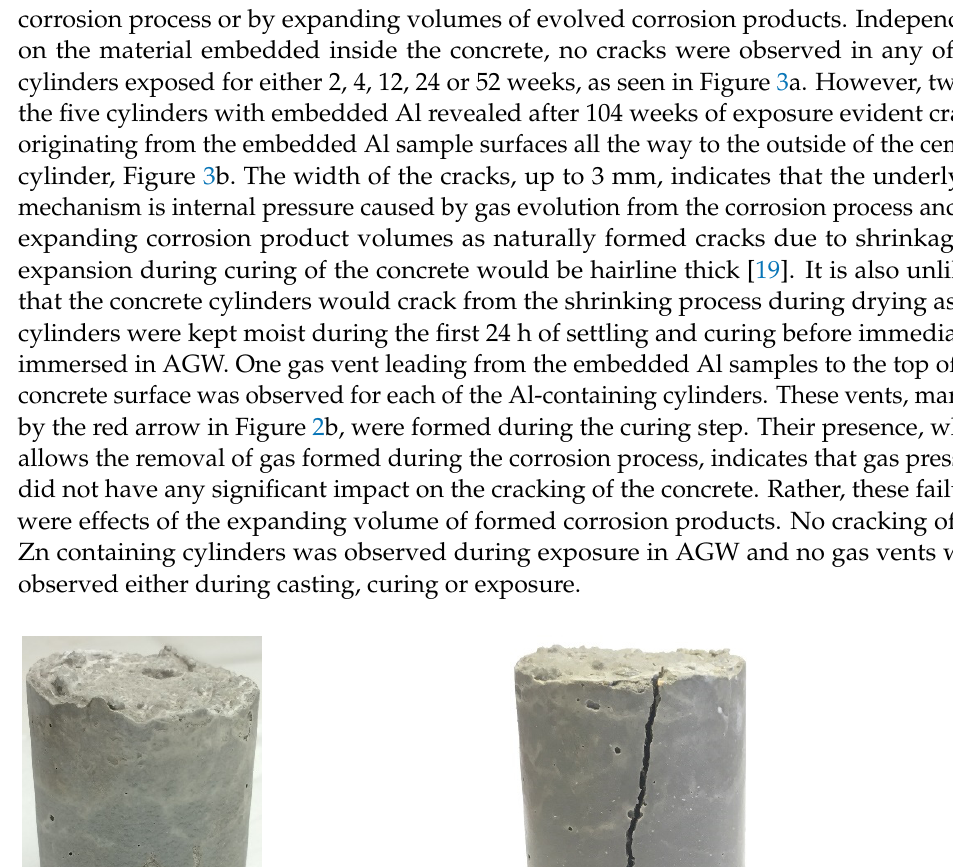
Figure 2. ( a ) Gas bubbles on the surface of wet concrete containing Al samples minutes after fin- ished pouring the concrete into moulds; ( b ) Gas vent outlet on the upper surface of concrete cured for 20 h.